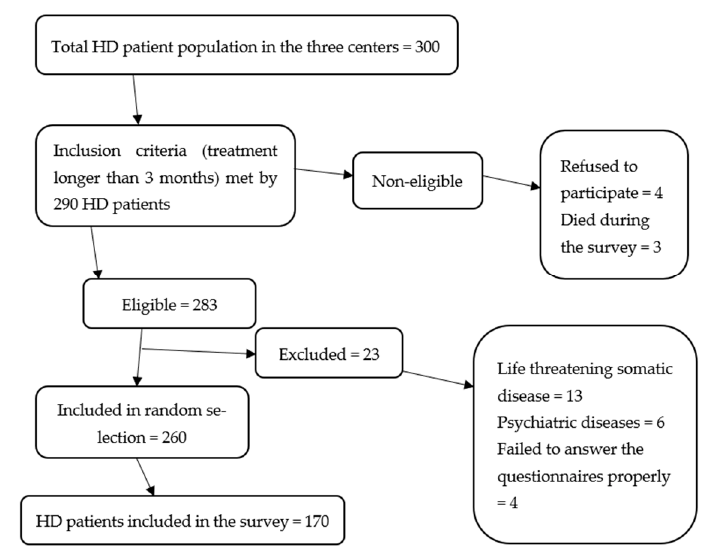
Figure 1. Flowchart of patient inclusion .